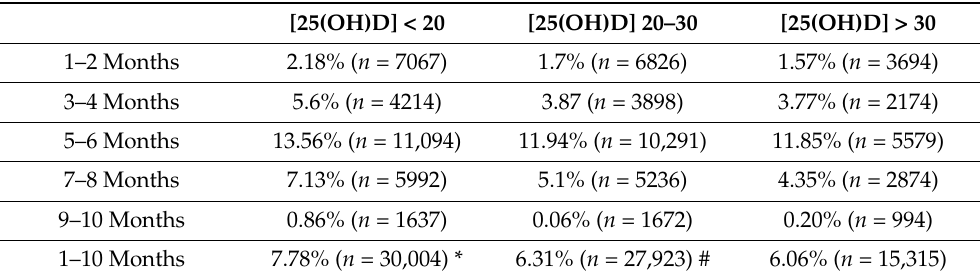
Table 2. The infectivity rate at each specific time period with each specific vitamin D level. Significant differences are marked by an asterisk or hash mark (*: p < 0.05 [25(OH)D] < 20 vs. [25(OH)D] >